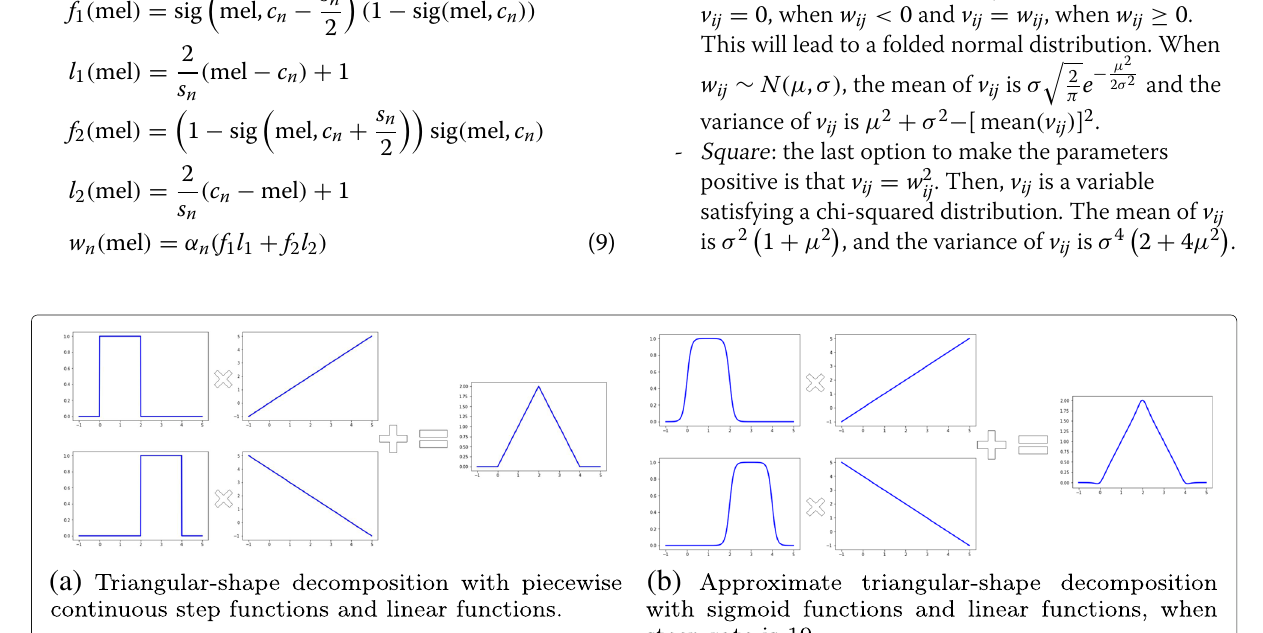
Fig. 3 Triangular-shape decomposition. a The accurate decomposition using piecewise continuous step functions and linear functions. b The approximate decomposition using sigmoid functions and linear